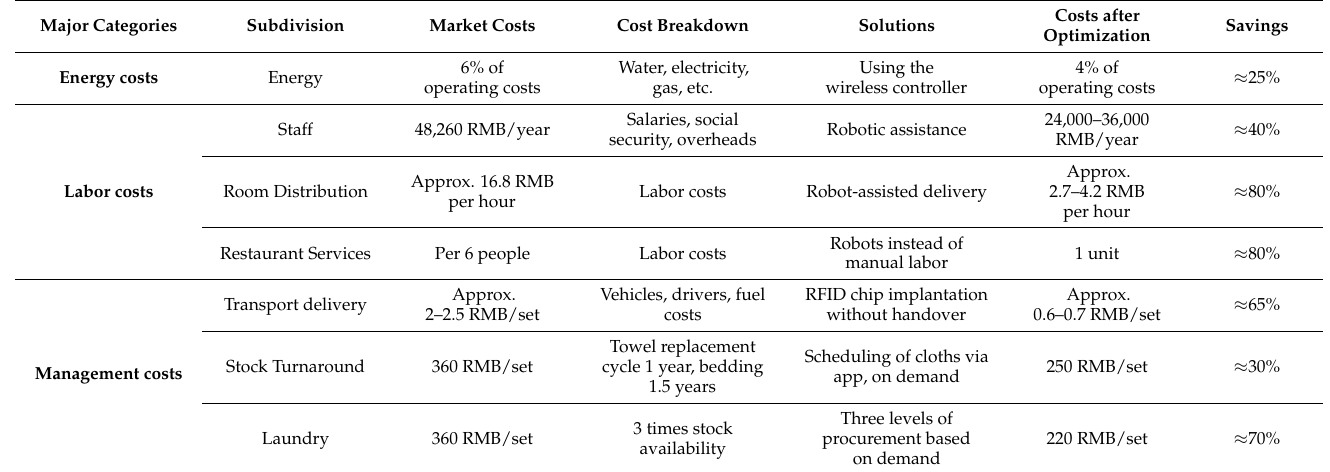
Table 2. IoT improvements to hotel costs in